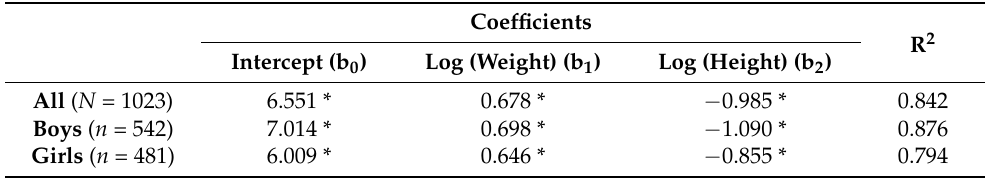
Table 2. Regression coefficients of the relationships among log of waist circumference (m), log of weight (kg), and log of height (m).